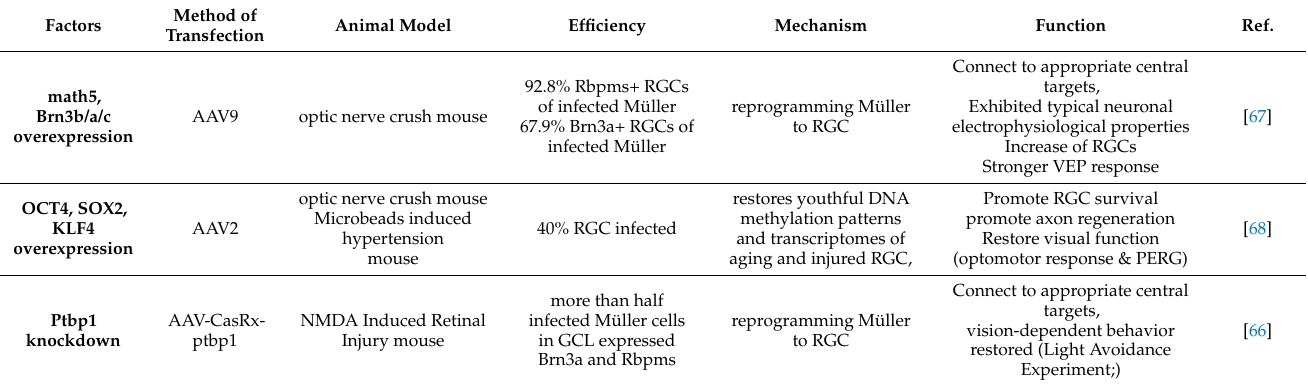
Table 3. Endogenous transdifferentiation and rescue of